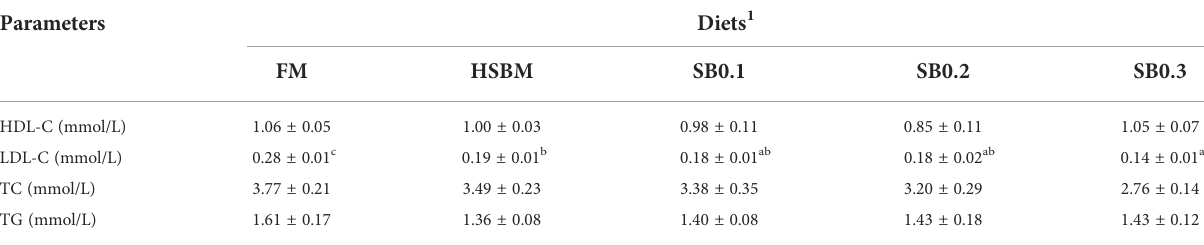
TABLE 4 Effect of sodium butyrate (SB) addition in high soybean meal (SBM) diets on plasma components of groupers in a 56-d feed period.